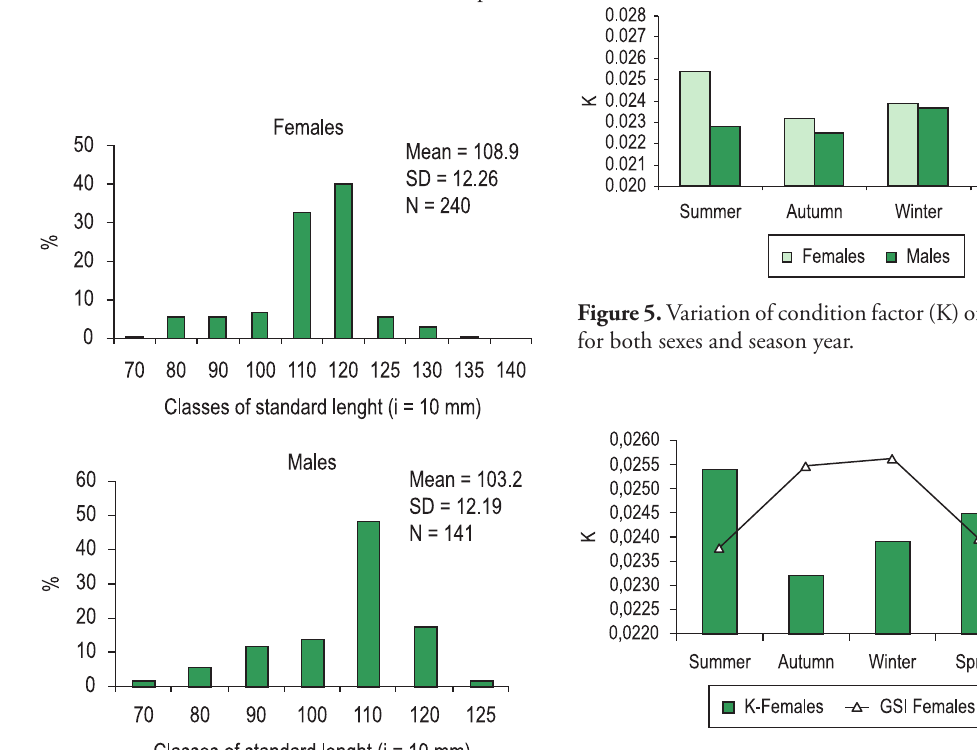
Figure 6. Variations in the gonad somatic index (GSI) and female condition factor (K) of A. fasciatus in each season of the